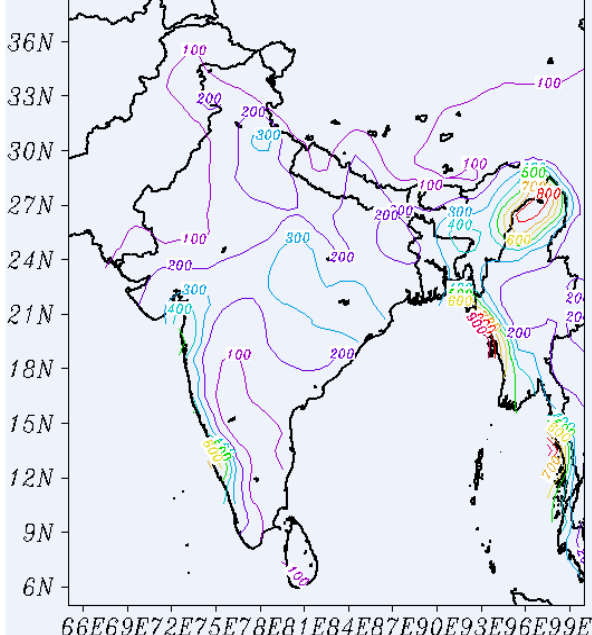
Fig. 11. NCEP rainfall (mm) 2002 (JJAS).